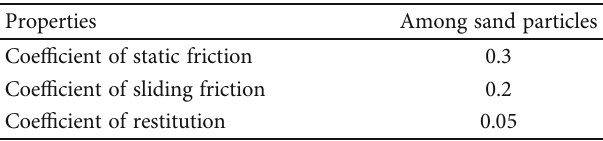
Table 3: Interaction parameters among sand particles